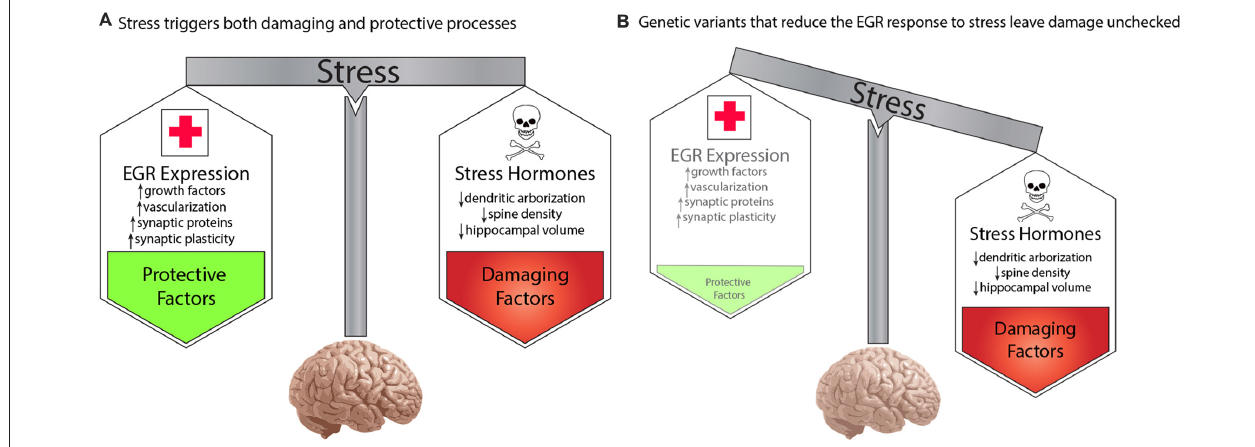
FIGURE 2 | A developmental model for genetic predisposition to stress susceptibility. (A) Stress hormones cause detrimental effects on the brain, such as decreased dendritic arborization, reduced density of synaptic spines, and decreased regional brain volumes, which are seen in schizophrenia. Stress also activates EGR family immediate early genes, which mediate numerous beneficial processes, such as growth factor response, vascularization, synaptic protein expression, and synaptic plasticity. The balance between these processes protects the brain from damage under stressful conditions. (B) Individuals carrying genetic variants that impair the activation of pathway proteins may be fine under normal conditions. However, in the context of stress, the damaging effects override the insufficient protective response, resulting in neurotoxic insults which, if sustained or repeated, may result in the neuropathology that gives rise to symptoms of schizophrenia. In this manner, genetic variations in genes of the proposed pathway create a predisposition to develop schizophrenia in a manner dependent upon the stress history of an